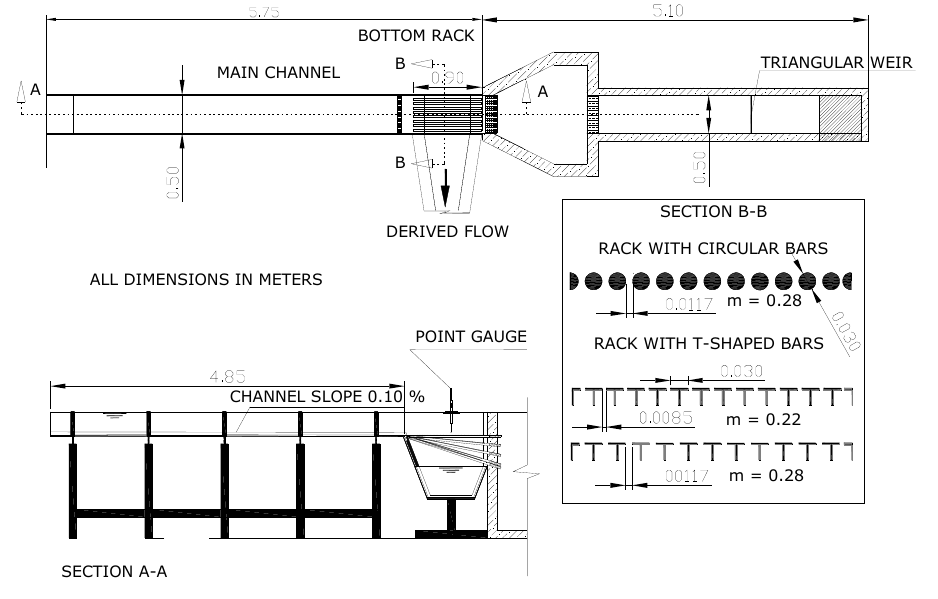
Figure 4. Scheme of the intake system physical device. Table 2. Characteristics of the racks tested with gravels in the present and previous works.